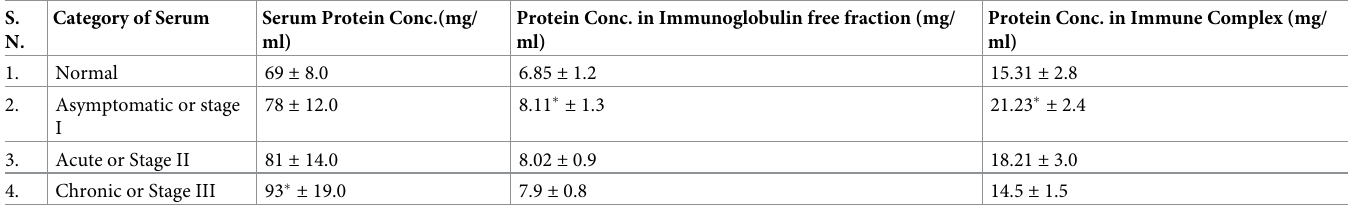
Table 1. Total protein concentration in different category of LF infected human serum. S.